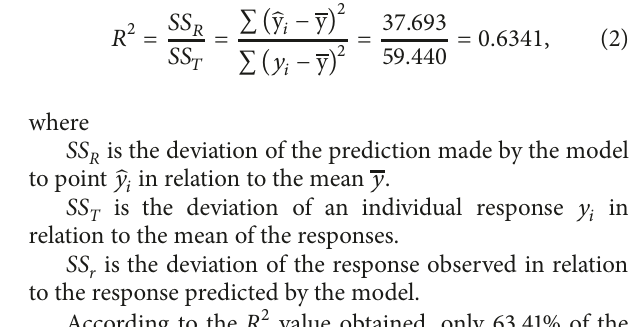
Table 2: Box-Behnken design (BBD) matrix with real and coded values of three factors studied, and response ( q